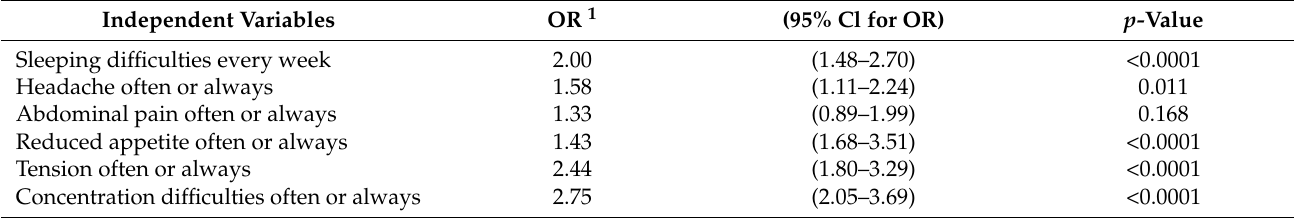
Table 3. Logistic regression analysis of factors related to sadness (often or always) among Swedish adolescents aged 15–17 years adjusted by gender and economic status ( n =